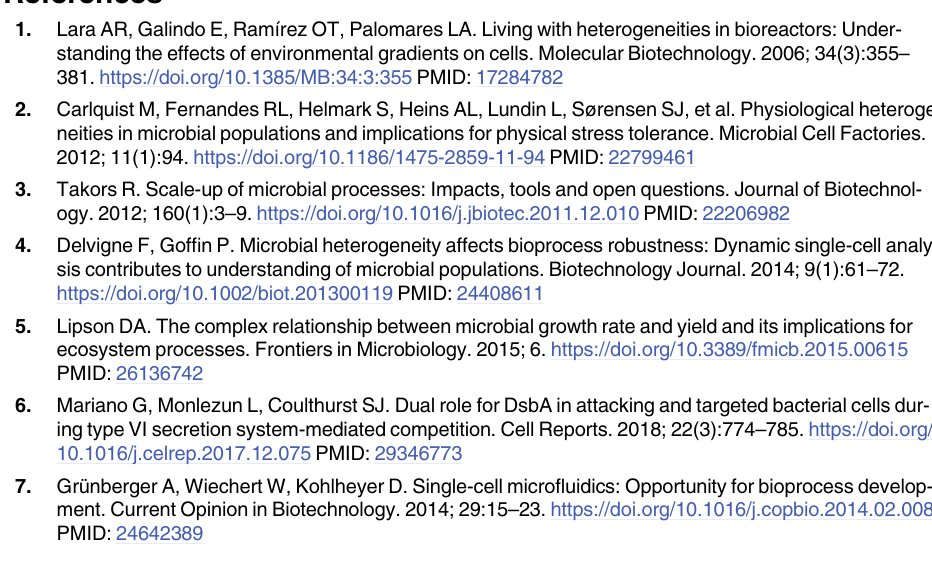
are color-coded (red: background, green: cell interior, blue: cell boundary). (PDF) S1 Video. Segmentation results of a growing C. glutamicum colony